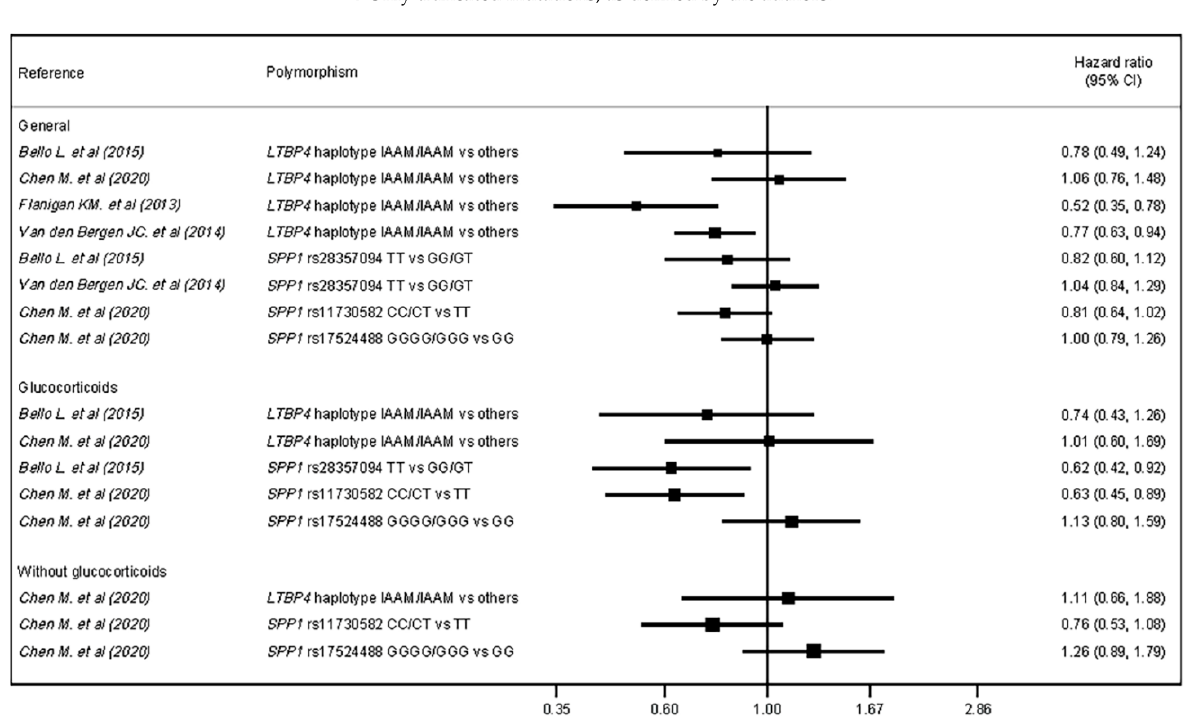
Figure 2. Forest plot for hazard ratio of LoA by genetic variant (polymorphism) and glucocorticoid subgroup.